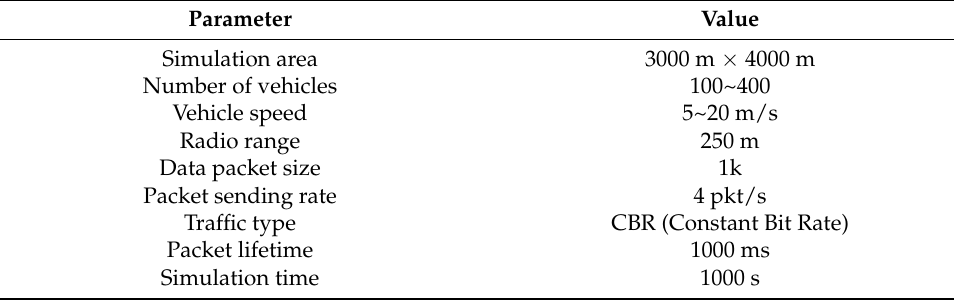
Figure 4. Simplified diagram of the map used in the simulation. Table 4. Parameters used in the